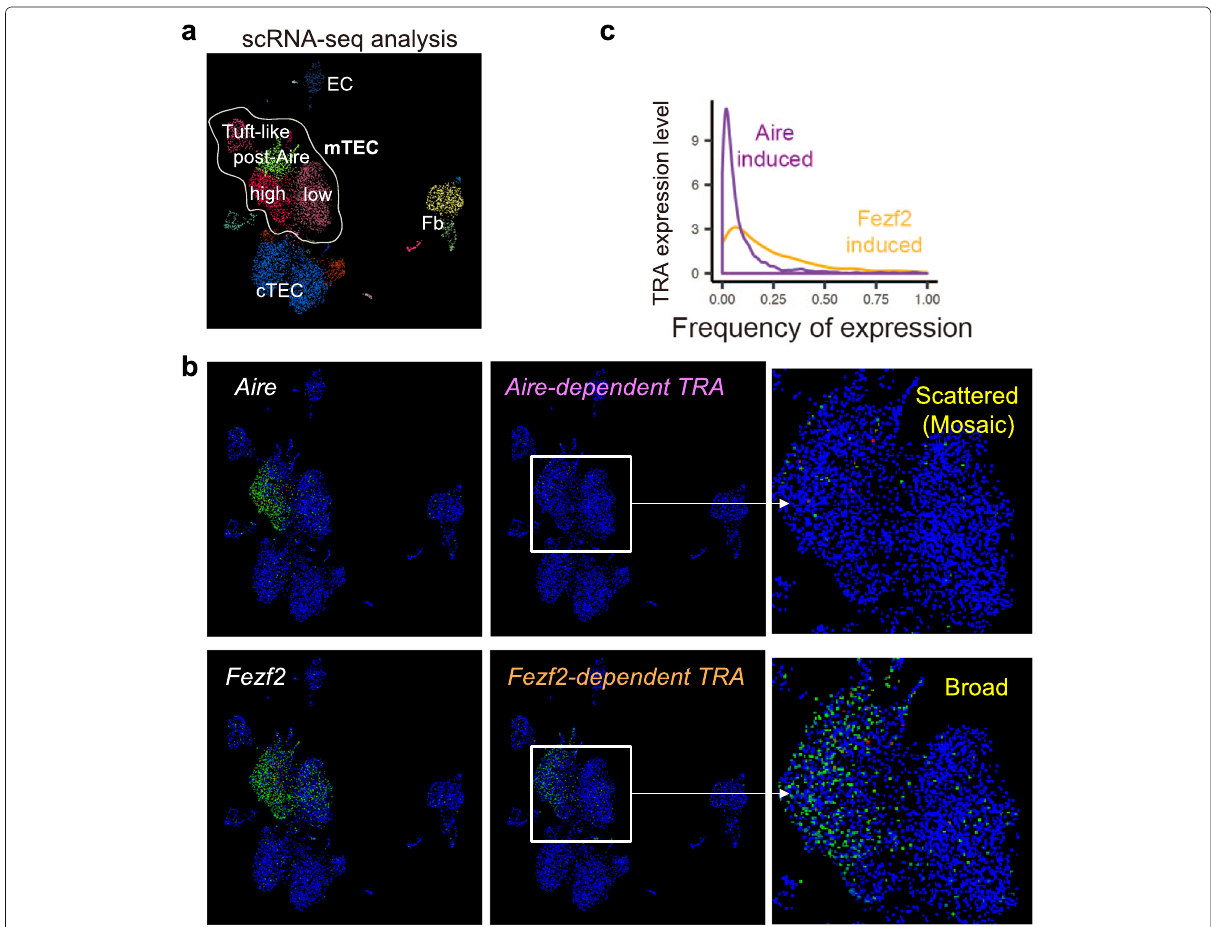
Fig. 1 The expression pattern of TRAs in the mTECs by scRNA-seq analysis: a scRNA-seq analysis of thymic stromal cells. b Mosaic expression pattern of Aire-dependent TRA (top, Ins2). Broad expression of Fezf2-dependent TRAs (bottom, Muc1). c Fezf2-dependent TRAs are more highly expressed in a mature mTEC than Aire-dependent